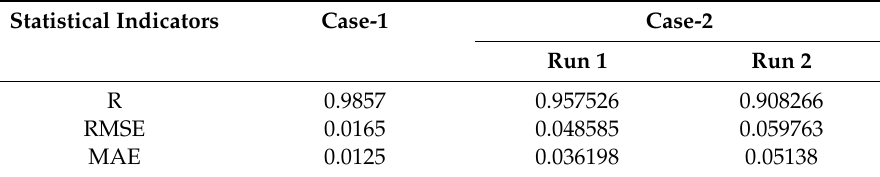
Figure 7. Porosity obtained from DEM simulations in comparison with the porosity measurement of Navaratnam et at. [ 41 ] ( a ) gravel flume, ( b ) vertical porosity variation.